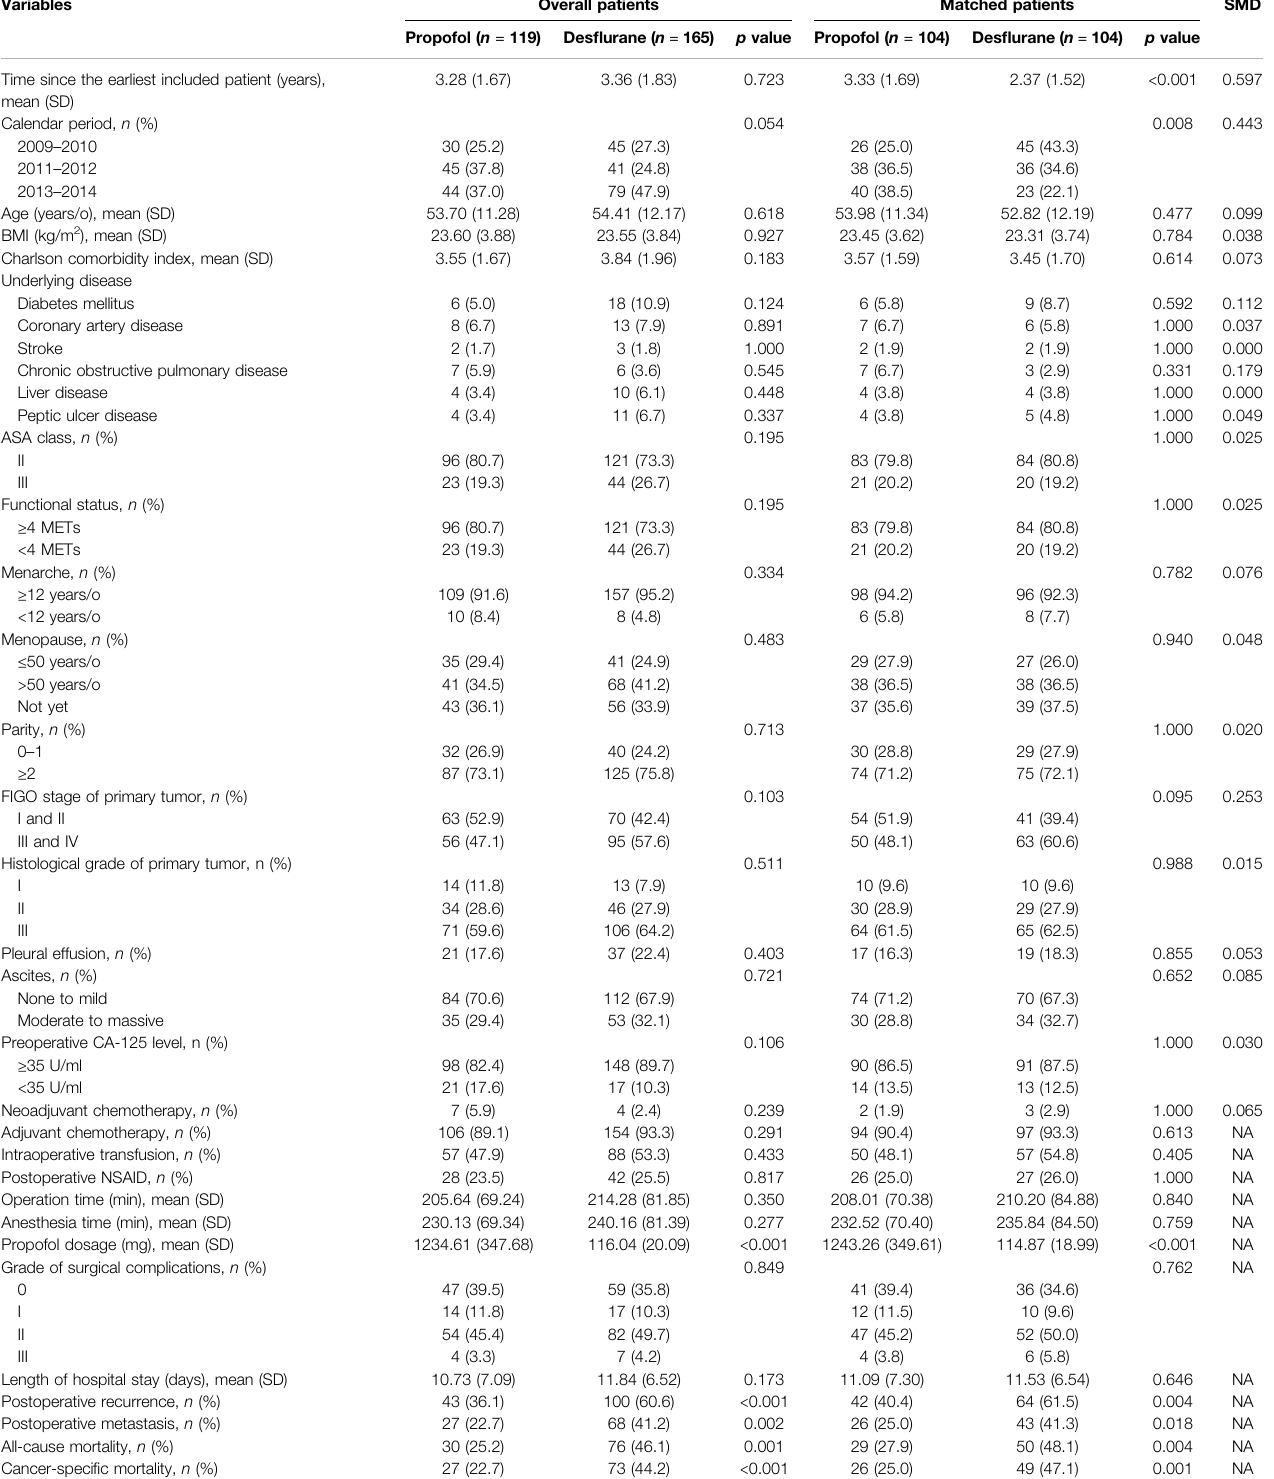
TABLE 1 | Patient and treatment characteristics for overall group and matched group after propensity scoring. Variables Overall